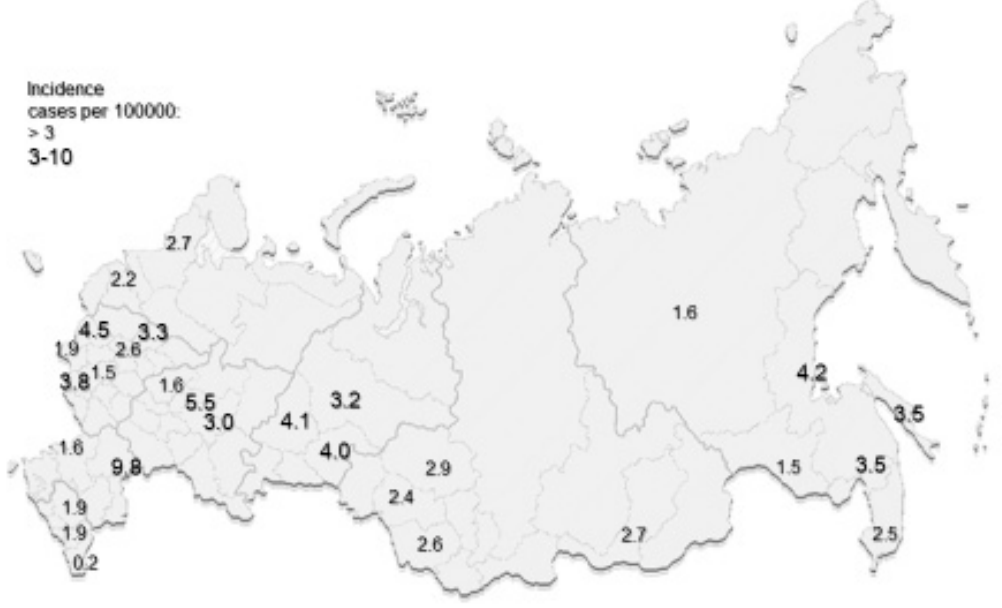
Figure 3. The latest data on MS incidence per 100,000 population in regions of the Russian Federation.